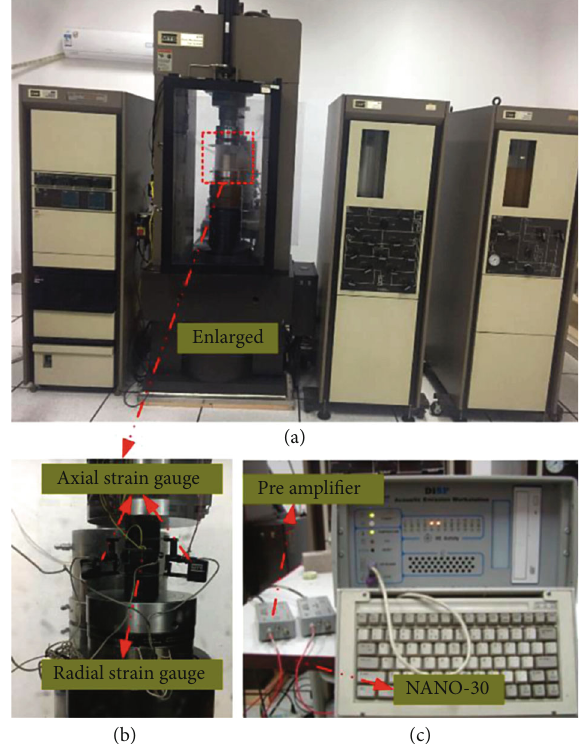
Figure 3: Diagram of the experimental system: (a) MTS 815 test system; (b) external measuring device; (c) AE